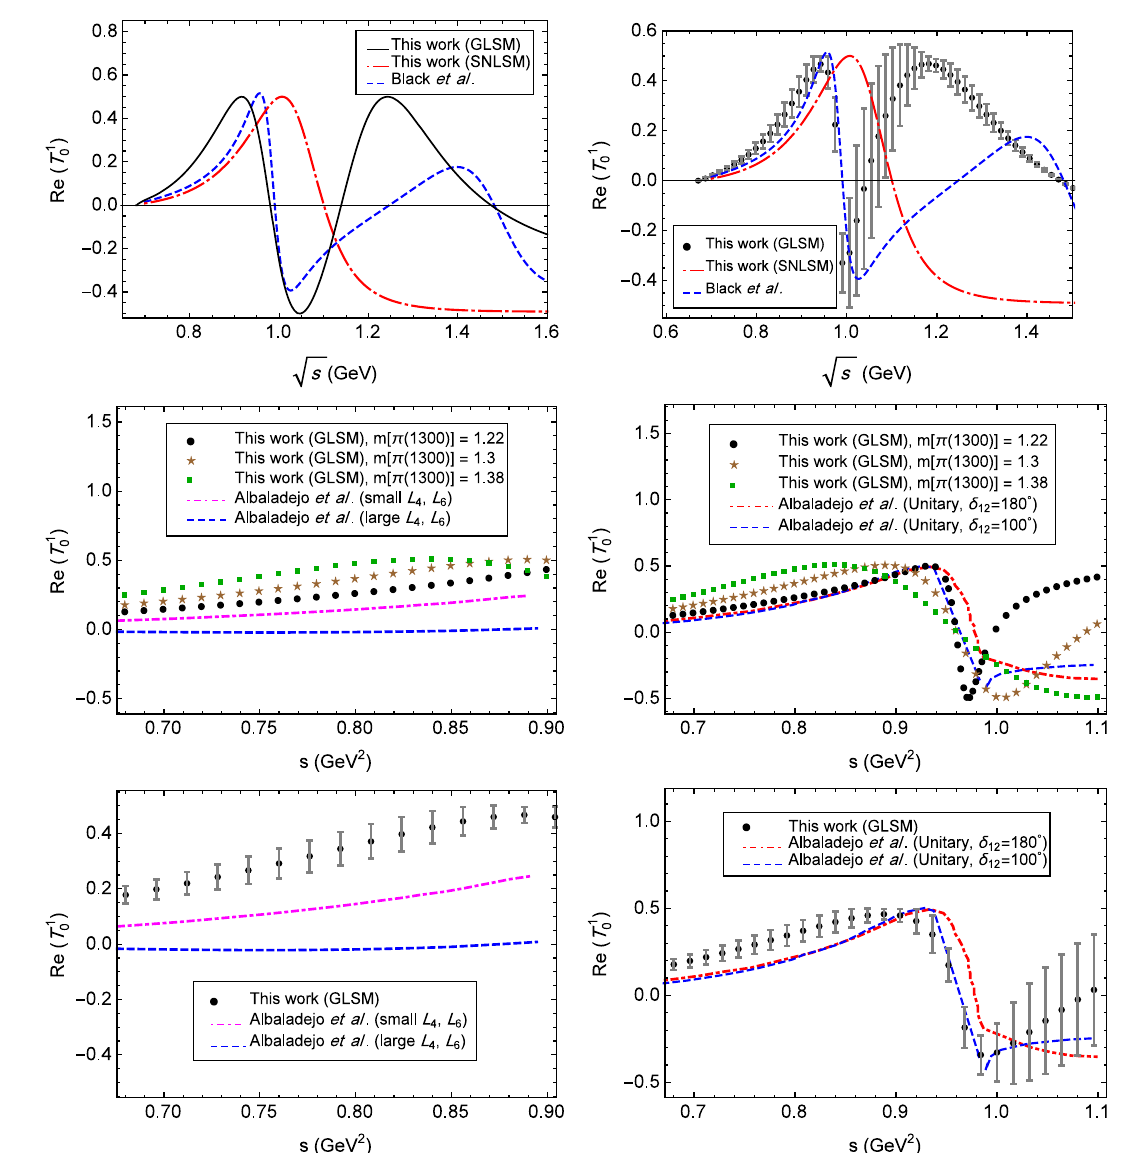
Fig. 9 The real part of the predicted K-matrix unitarized πη scattering amplitude computed in GLSM (for a typical value of m [ π( 1300 ) ] and A 3 / A 1 ) is compared with single nonet linear sigma model (SNLSM) and the nonlinear sigma model (NLSM) of Ref. [138] (top left). In the top right figure, the averages (dots) and standard deviations (error bars) of the prediction of GLSM resulted from variation of m [ π( 1300 ) ] and A 3 / A 1 show much less sensitivity below 1 GeV. Up to about 1 GeV, the results qualitatively agree, however above 1 GeV the GLSM and NLSM only have a similar functional behavior (increasing to a maxi-